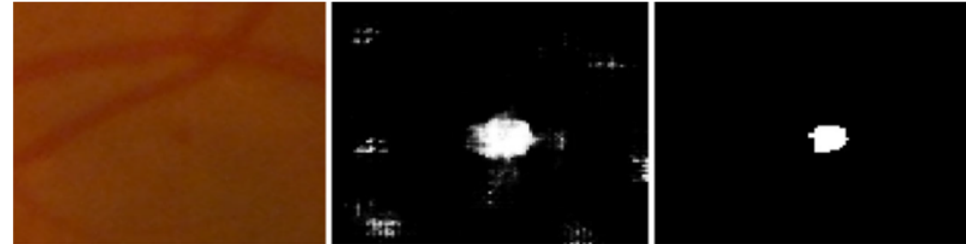
Figure 9. Left to right, stepwise microaneurysms detection: original image, MA sign before optimization, MA sign after optimization.